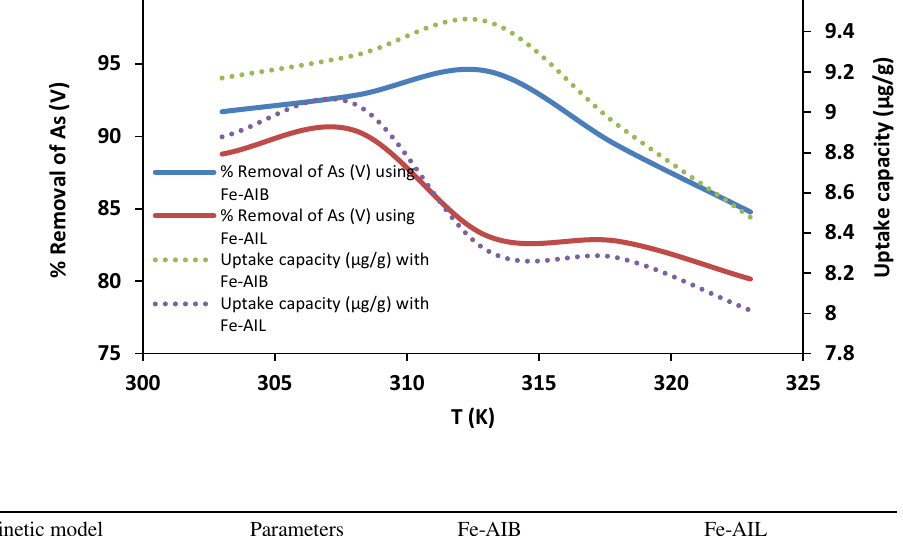
Table 5 Kinetic parameters for adsorption of arsenic by Fe-AIB and